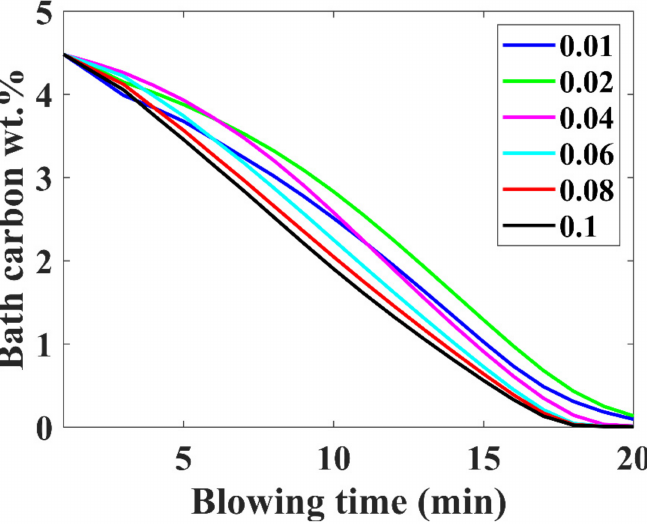
Figure 6. Variation in carbon wt % with blowing time at different inialpha values of 0.01 (blue), 0.02 (green), 0.04 (magenta), 0.06 (cyan), 0.08 (red), and 0.1